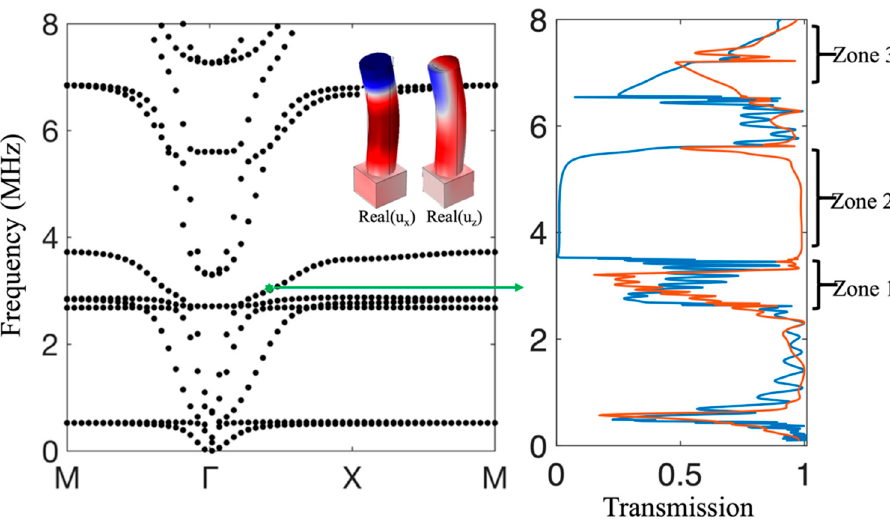
Figure 3. Left panel: Dispersion curves of the asymmetric-sided pillared meta-plate along the first irreducible Brillouin zone. Due to the asymmetry with respect to the middle plane of the plate, the dispersion curves cannot be decoupled, and behave as hybridized bands. Right panel: Transmission spectra of A 0 (blue) and S 0 (orange) Lamb waves across 15 asymmetric sided unit cells along the Г X direction. The transmissions in Frequency Zones 1–3 change from those in Figure 2, with non-vanishing values for both Lamb modes. The real parts of u x and u z of the eigenstate at the green dot in the dispersion curves are plotted as the insets where the red and blue colors mean positive and negative values, respectively.